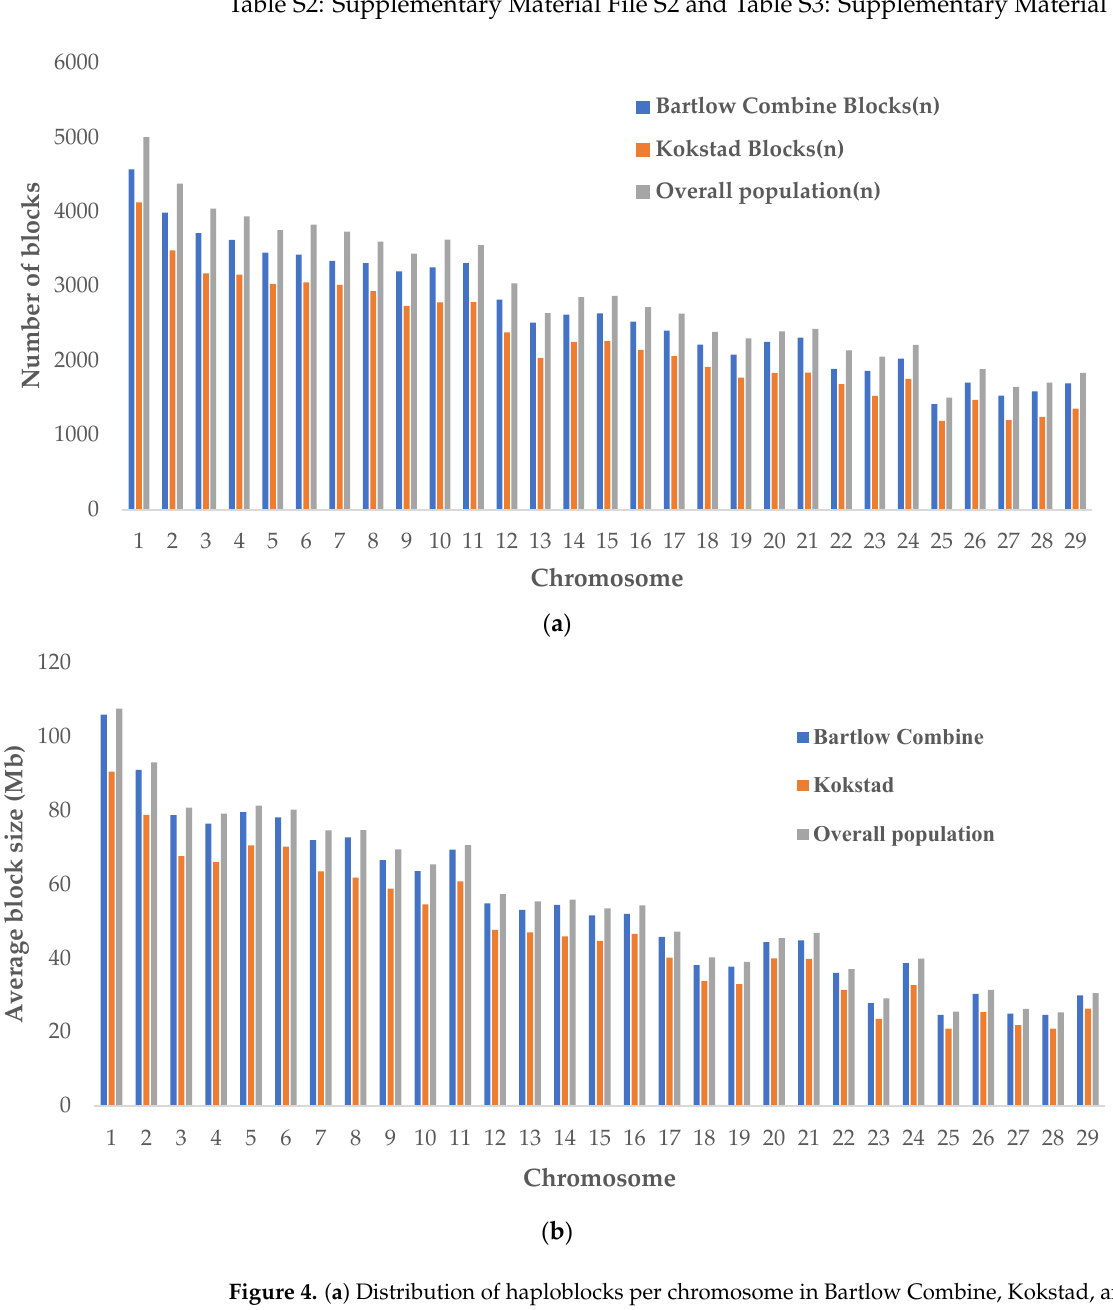
Table S2: Supplementary Material File S2 and Table S3: Supplementary Material File S3).